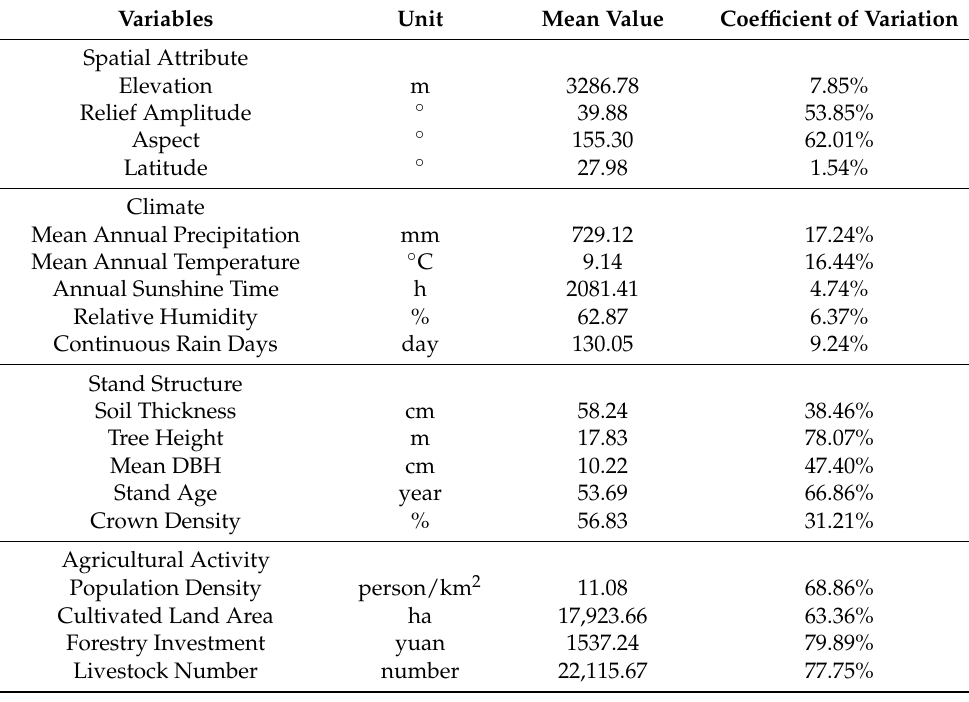
Table 1. Descriptions of variables.